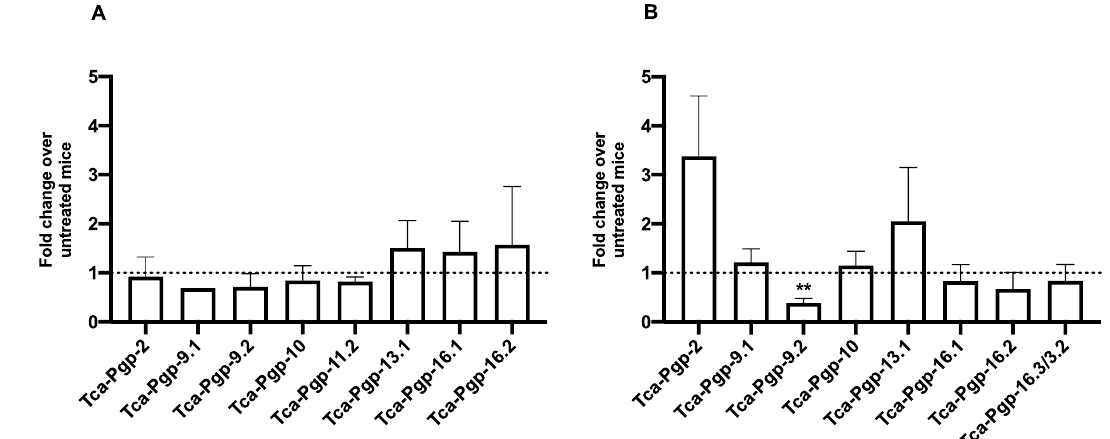
Figure 7. Mean fold change ± SE in expression of P-gp genes in larvae from mice treated with ( A ) ivermectin or ( B ) moxidectin compared to untreated controls. Fold change was calculated using the efficiency corrected ΔCt method using T. canis 18S as the reference gene. (Asterisk represents statistical difference from untreated controls ** p < 0.01).